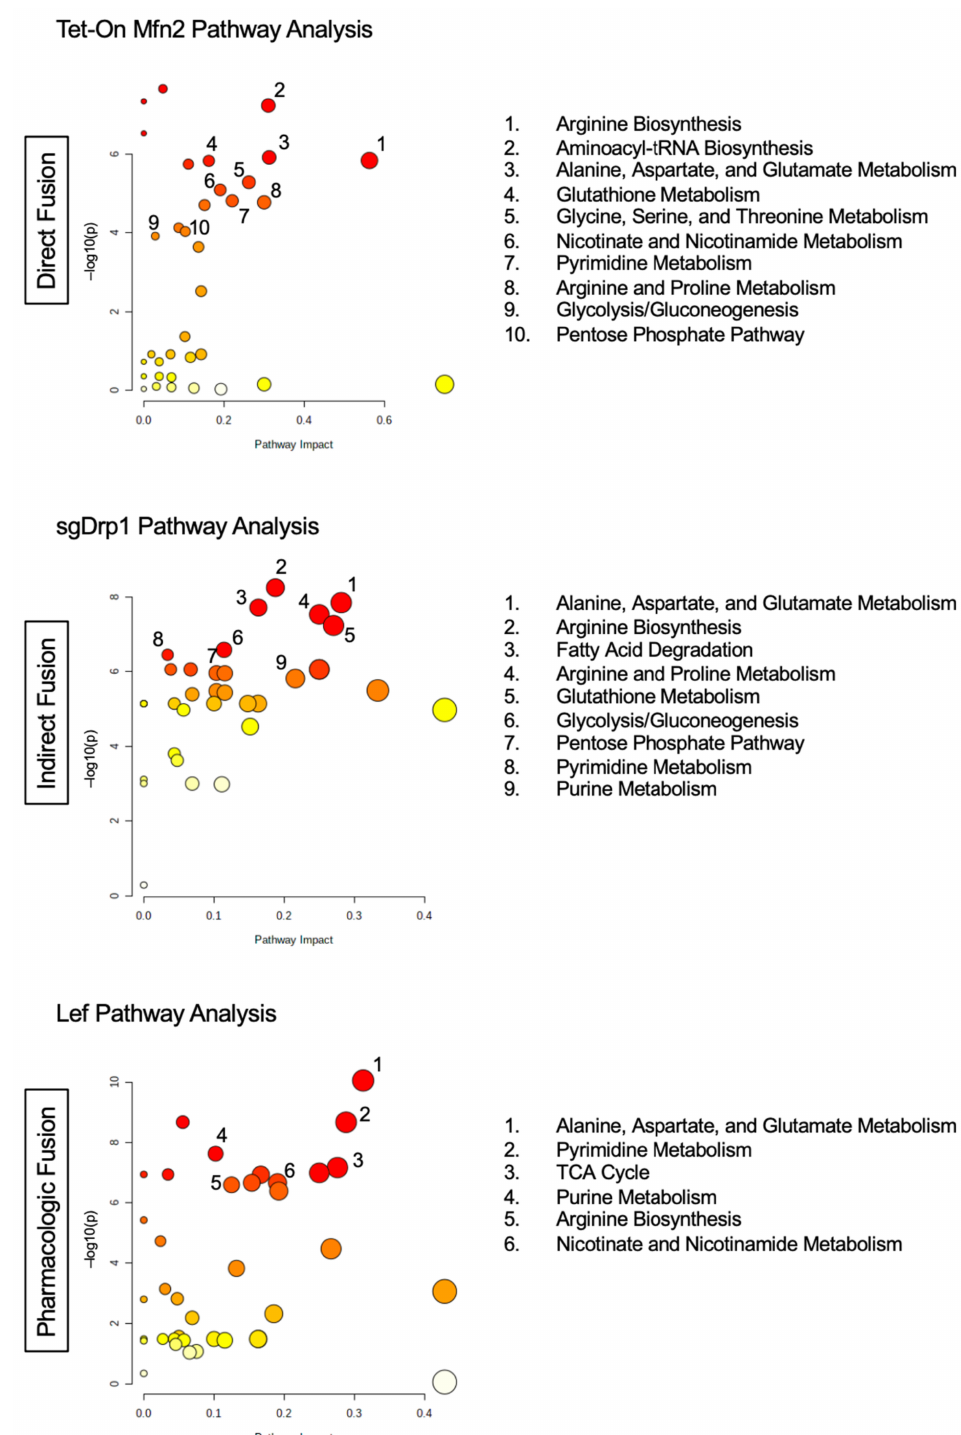
Figure 6. Pathway analysis of overlapped discriminant metabolites from direct fusion in Tet-On Mfn2, indirect fusion in sgDrp1, and pharmacologic fusion in leflunomide-treated KPC